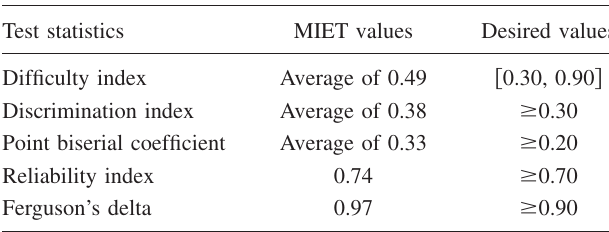
FIG. 1. (cid:1) Color (cid:2) Vector representation of observed variables: (cid:1) a (cid:2) correlation of two vectors can be represented as the projection of one vector onto the other; (cid:1) b (cid:2) three dimensions are needed to rep- resent three vectors.